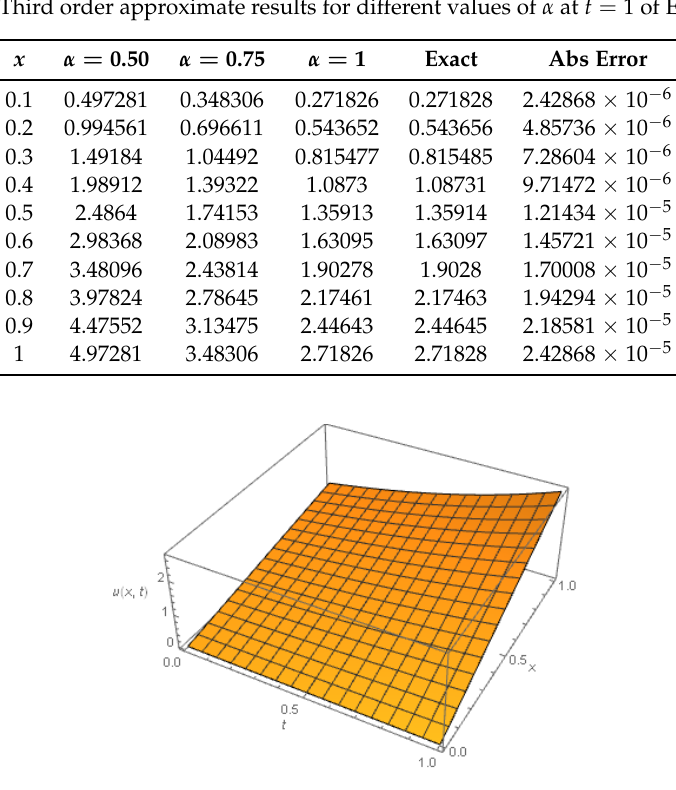
values of (cid:11)